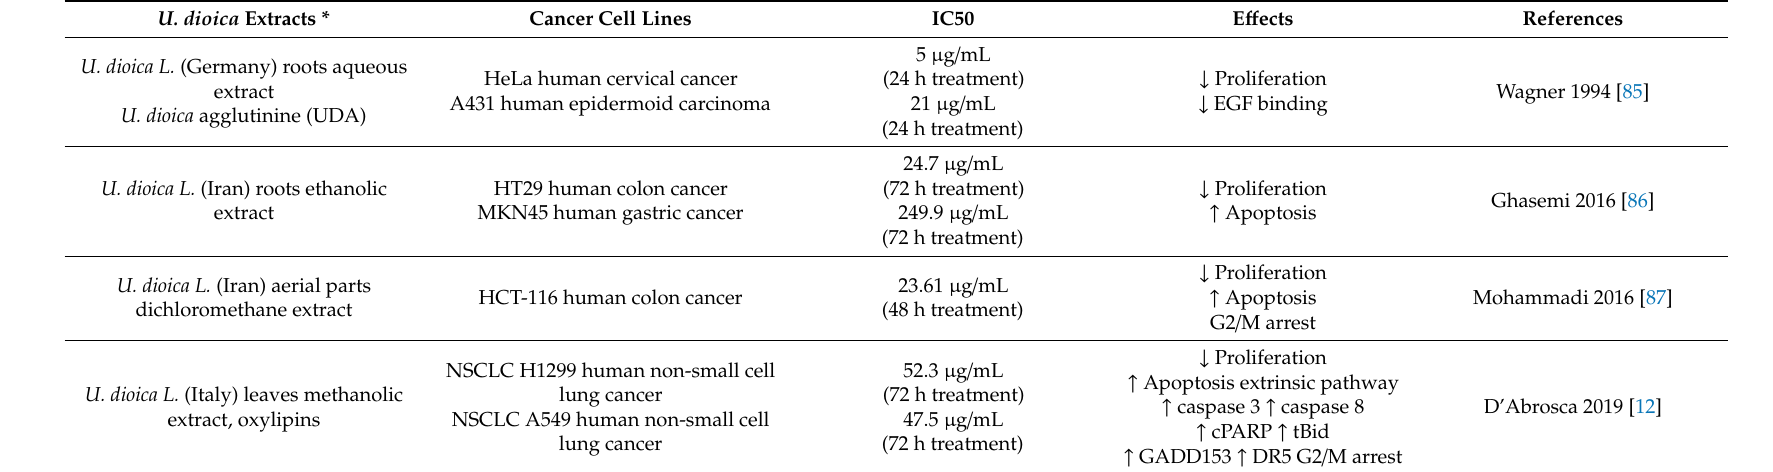
Table 1. Anti-cancer activities of U. dioica : cervical, epidermoid, colon, gastric and lung